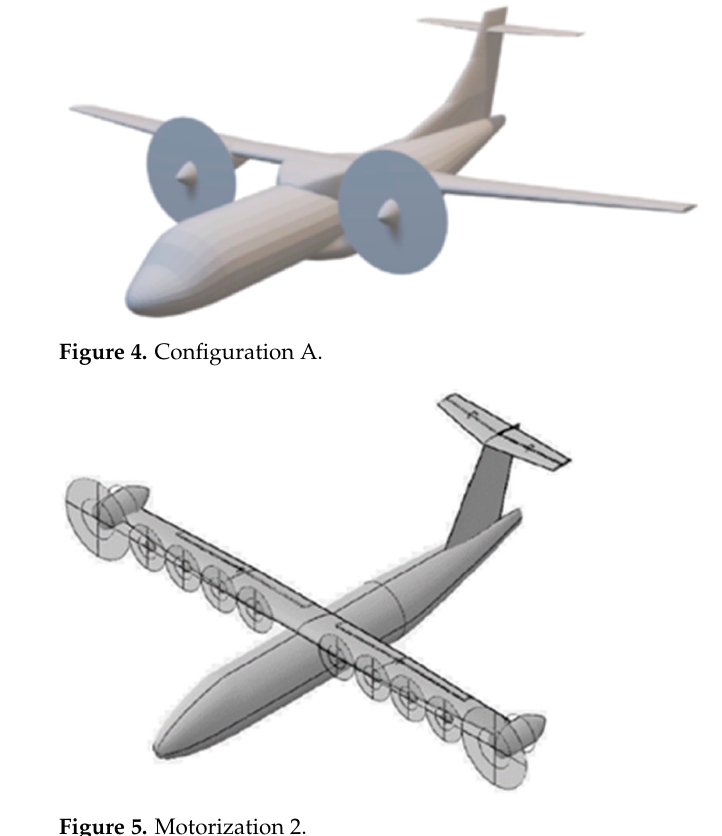
Figure 5. Motorization 2.